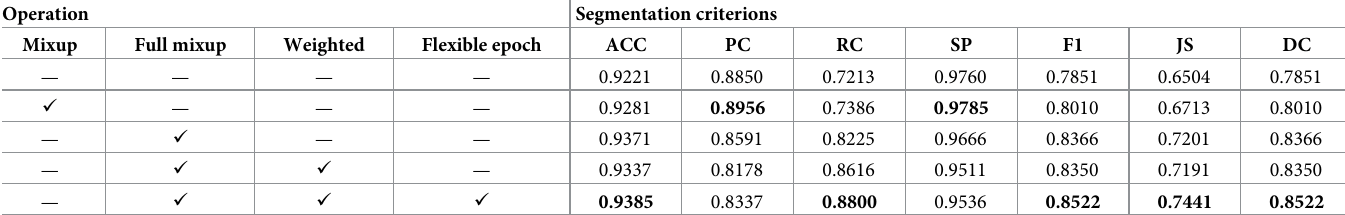
Table 2. Ablation results of segmentation criterions.